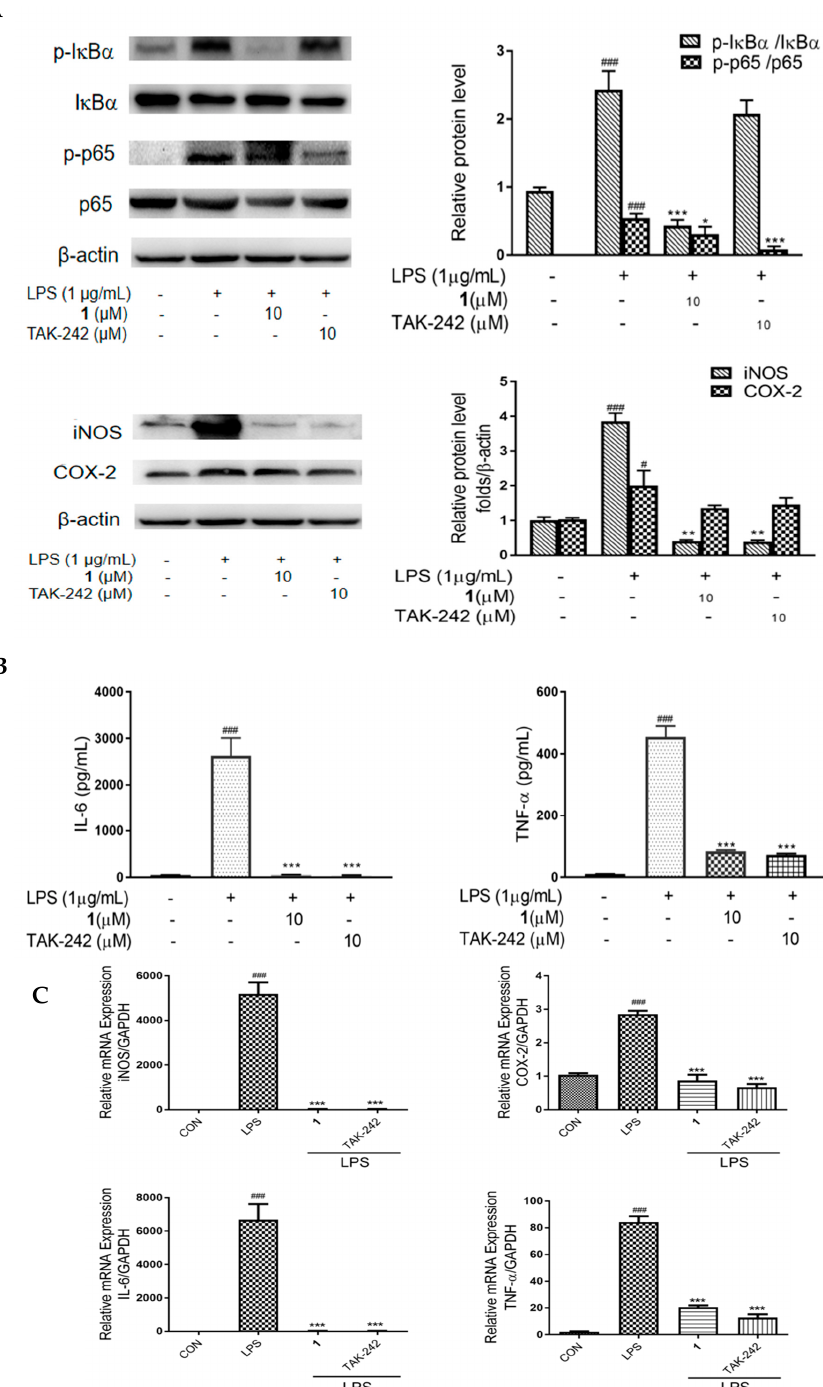
Figure 6. Effect of 1 on phosphorylation of NF- κ B subunits, and the expression of pro-inflammatory cytokines in LPS-induced RAW 264.7 macrophages. Cells were incubated with 1 (10 µ M) or TAK-242 (10 µ M) and LPS (1 µ g / mL) for 24 h. ( A ) Western blotting was performed to detect the expression of I κ B α , p-I κ B α , p65, p-p65, iNOS and COX-2. β -Actin served as the internal control. Quantification of immunoreactive protein bands is shown via bar graphs. ( B ) ELISA was determined to measure the production of IL-6 and TNF- α . ( C ) RT-PCR was performed to detect the mRNA levels of iNOS, COX-2, IL-6 and TNF- α . GAPDH was used as the internal control. Values are representative of three independent experiments. # p < 0.05, ### p < 0.005 vs. control cells. * p < 0.05, ** p < 0.01, *** p < 0.005 vs. LPS-induced